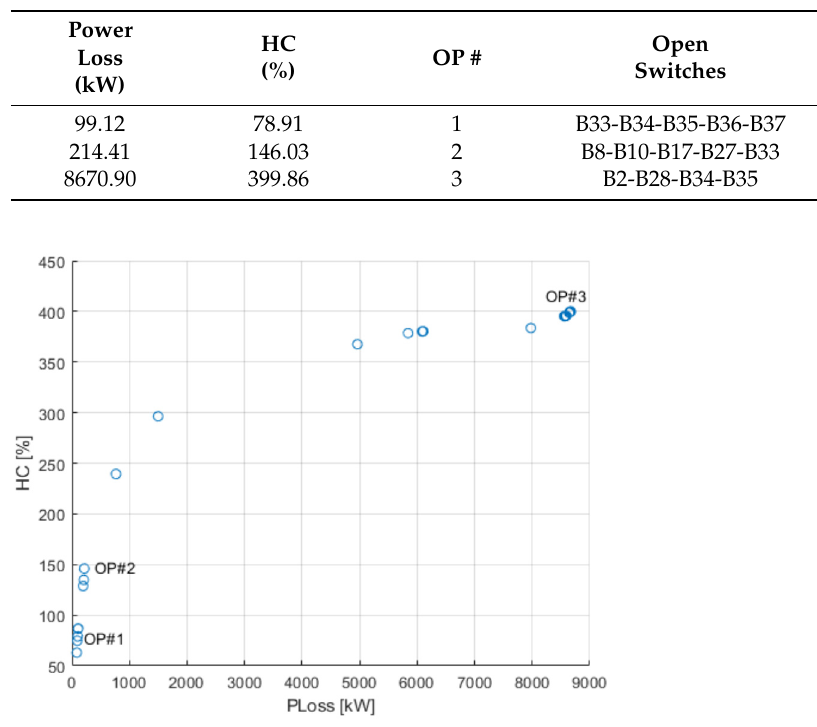
Table 9. Nondominated solutions from MOAIS, comparison with [12].